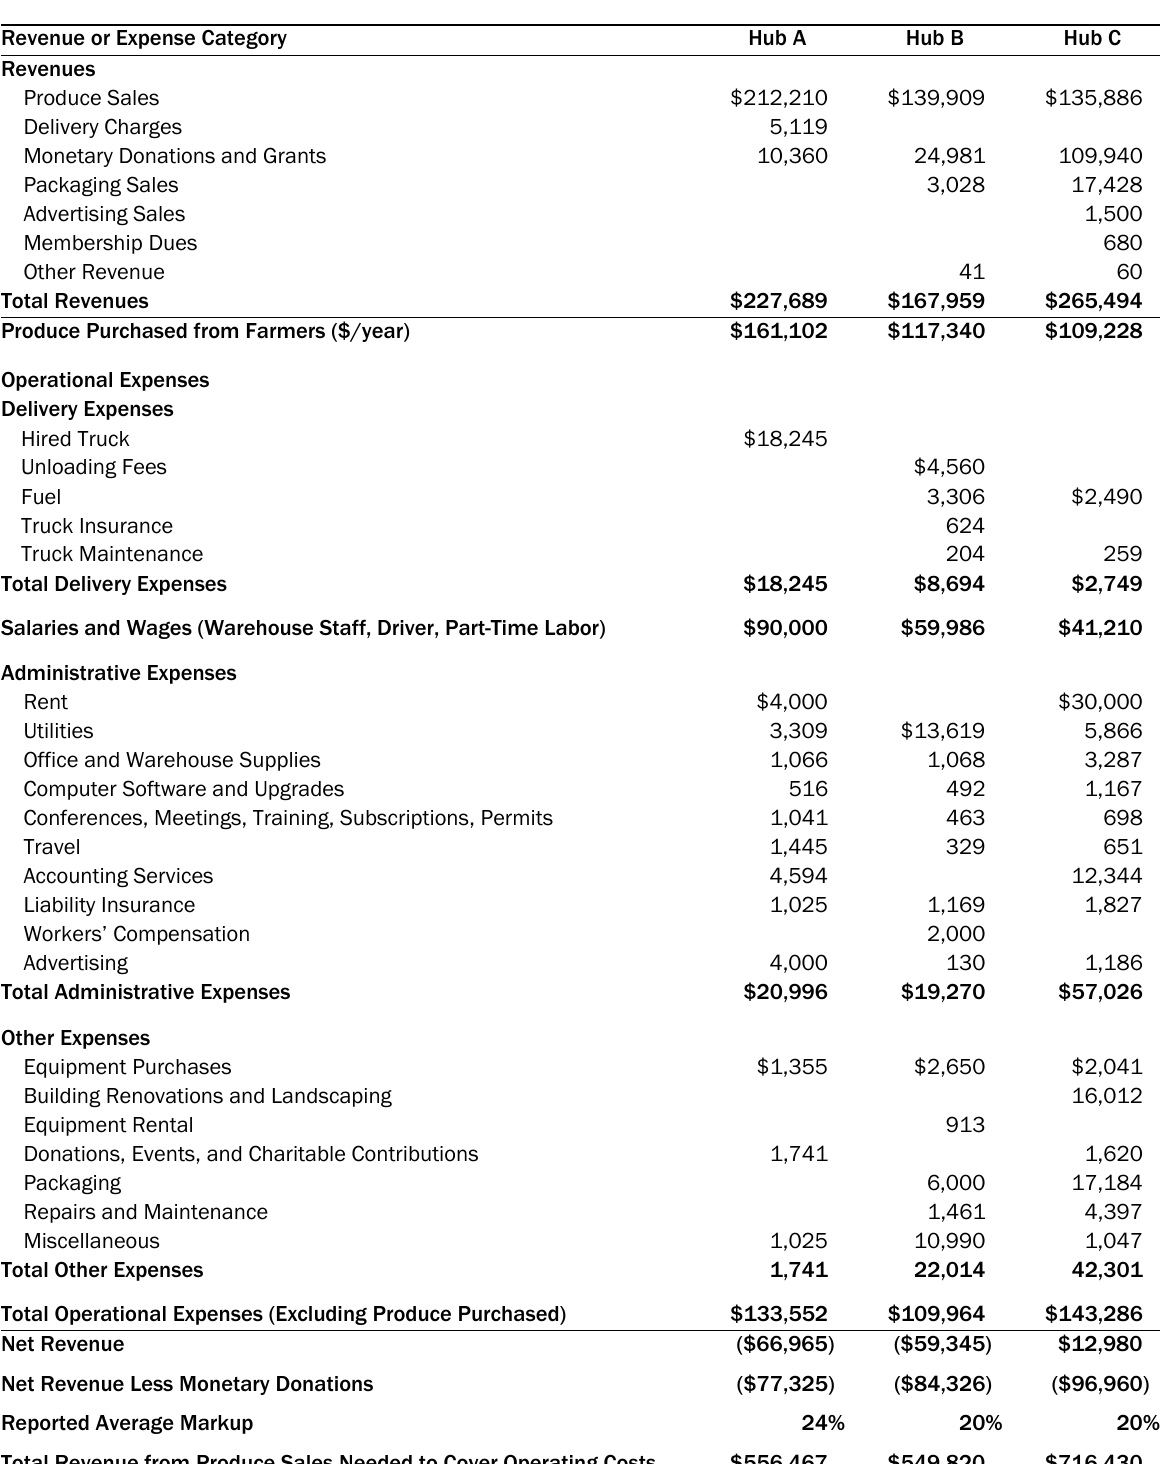
Table 1. Annual Revenues and Expenses of Three Food Hub Businesses,